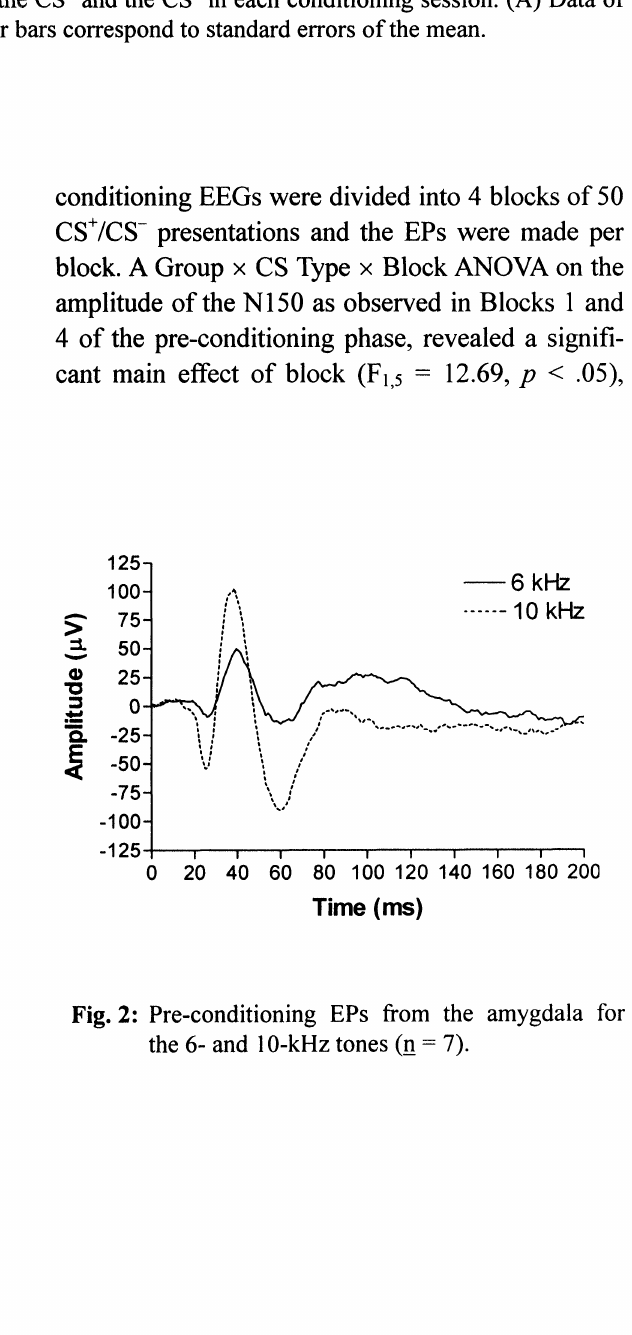
Fig. 1" Groups’ mean time spent freezing in response to the CS + and the CS- in each conditioning session. (A) Data of Group (n 3). (B) Data of Group 2 (n 4). Error bars correspond to standard errors of the mean.